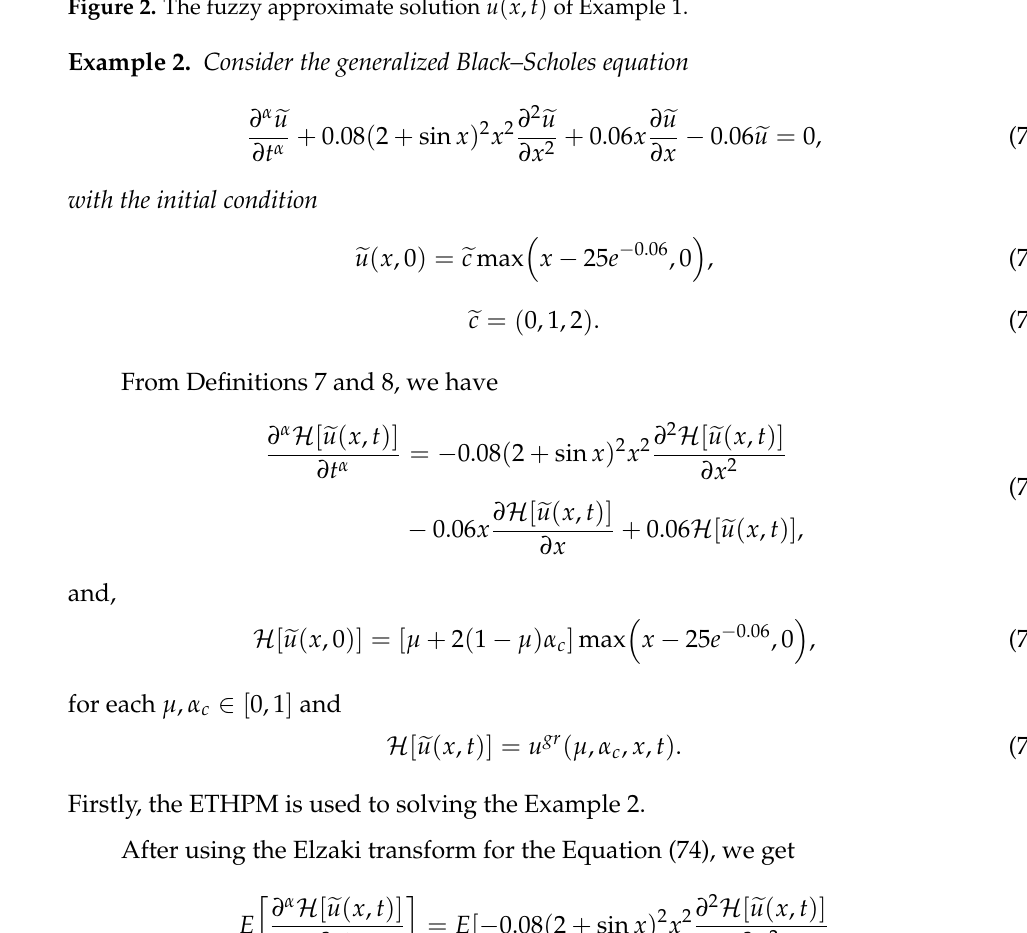
Figure 2. The fuzzy approximate solution (cid:101) u ( x , t ) of Example